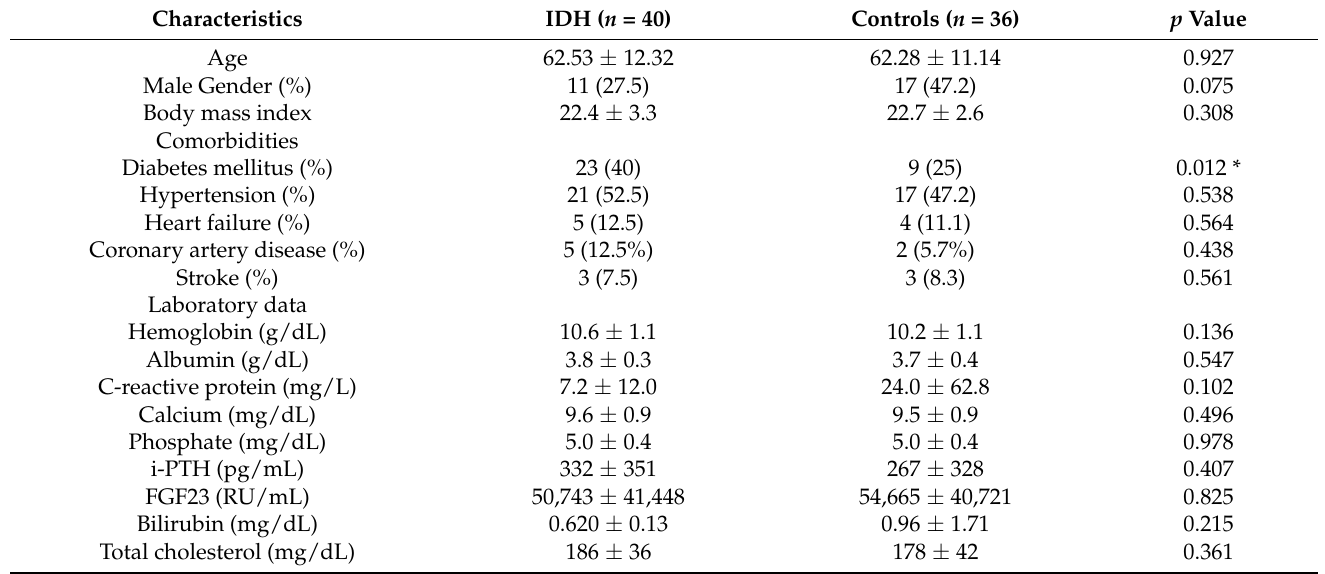
Table 1. Baseline Characteristics of study